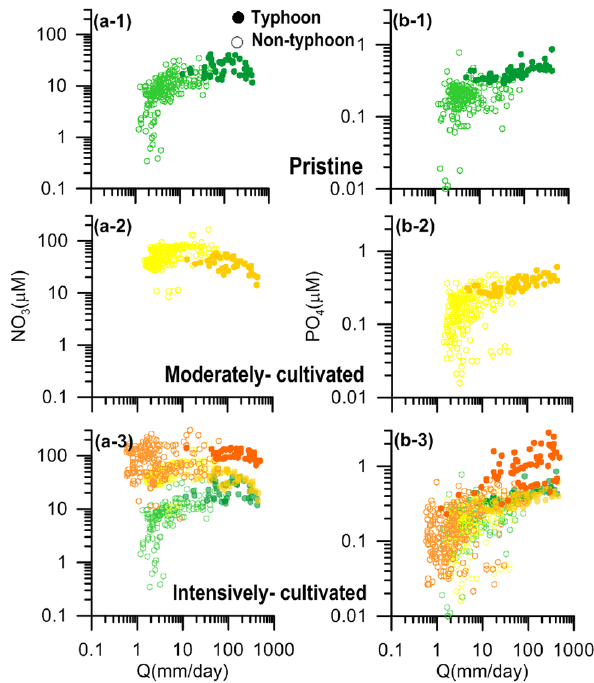
Fig. 4. The relation of observed (a) nitrate concentration and (b) phosphate concentration against runoff depth in the pristine (-1, green), moderately cultivated (-2, yellow) and intensively cultivated watersheds (-3, orange), respectively. Solid and hollow circles stand for typhoon and non-typhoon samples, separately. For the plots of intensively cultivated watershed, data in the other two watersheds were overlaid as